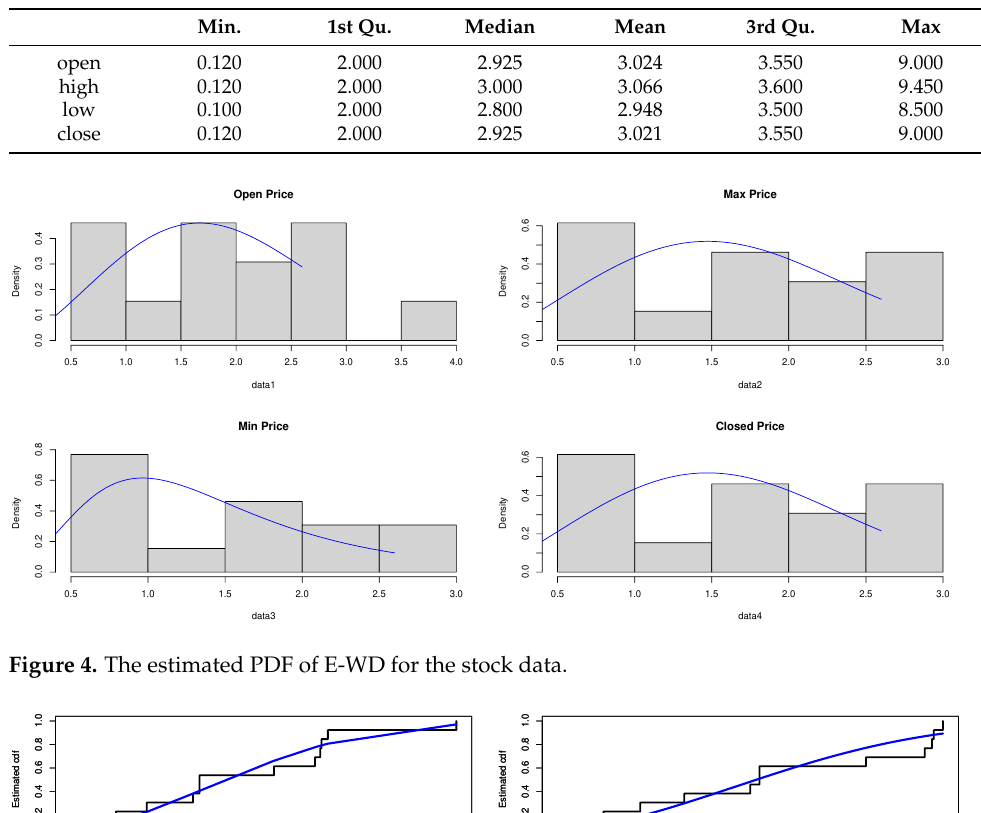
Figure 4. The estimated PDF of E-WD for the stock data.